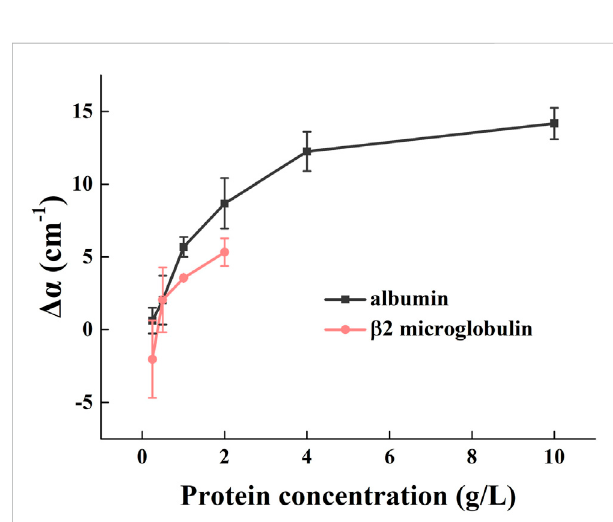
Effect of different types and concentrations of protein on urinary THz absorption. At 1.0 THz, the absorption spectra of albumin and β 2 microglobulin at different concentrations. Δα = α (c) - α (urine), where α (urine) is absorption coef fi cient of urine before protein